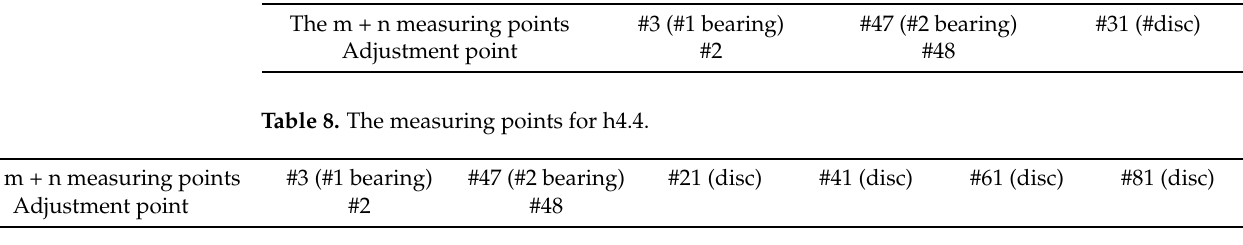
Table 7. The measuring points for h1.1.